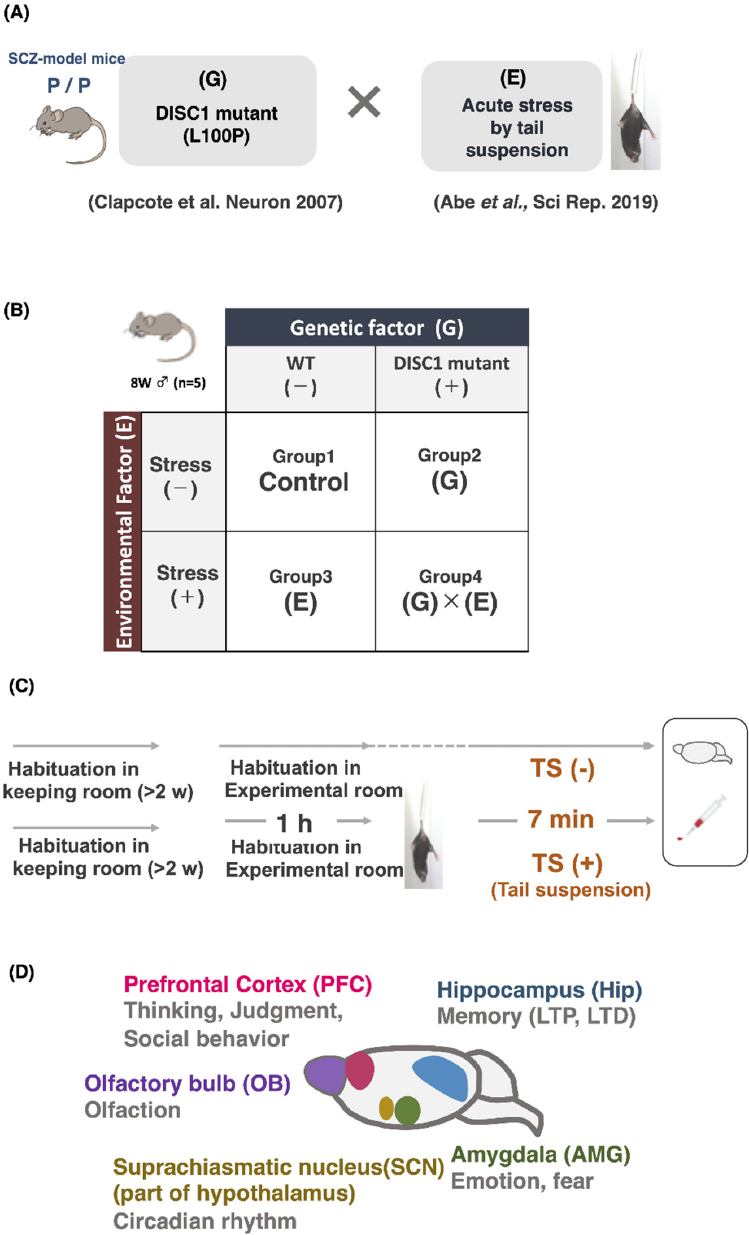
Figure 1. Experimental design of this study. ( A ) Interaction between genetic factor (G) and environ- mental factor (E), G × E. In this study, a schizophrenia mouse model (DISC1 mutant mice, L100P) was used as a contributing genetic factor. The environmental factor was established by exposing the mice to an acute stress condition, tail suspension. ( B ) Experimental design. Mice were divided into the control, G, E, and G × E groups, with five male mice per group. ( C ) Tail suspension test. Before this, pre-habituated mice (at least 2 weeks before experiment) were habituated for 1 h in the experimental room. Immediately after the end of the experiment, serum collection and brain extraction were performed. ( D ) Brain regions used in this study. The extraction was performed as described by Abe et